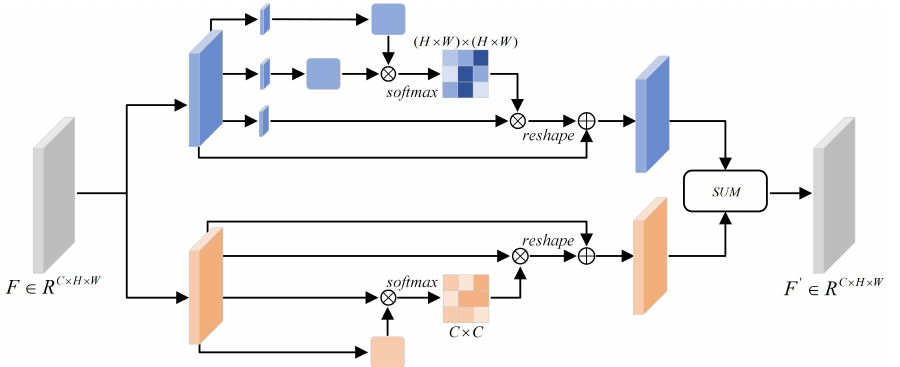
Figure 3. Dual attention